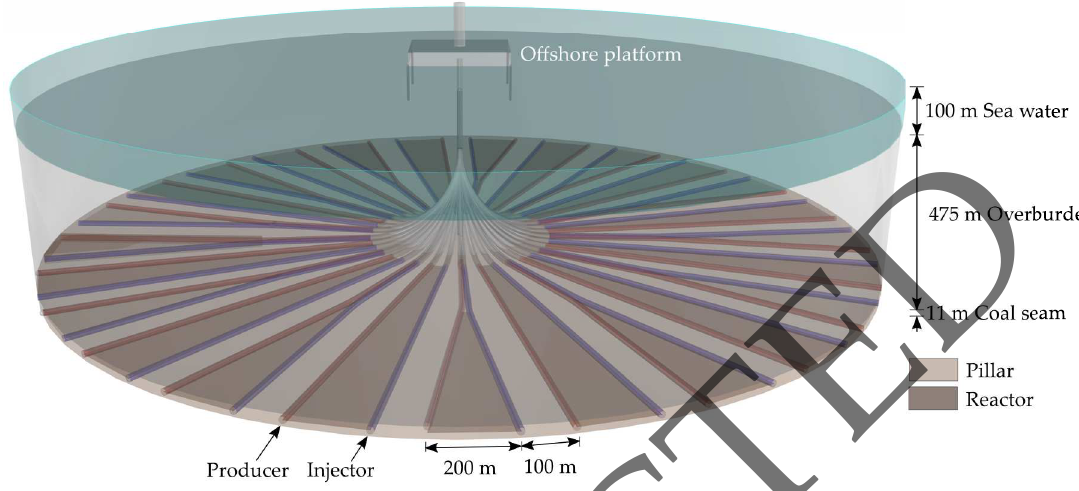
Figure 6. Computer-Aided Design (CAD) model visualizing the proposed Parallel Controlled Retracting Injection Point (P-CRIP) offshore Underground Coal Gasification (UCG) well design with twelve “long” and 13 “short” channel systems. Figure copyright [36] (modified), licensed under CC BY-NC-ND 4.0.